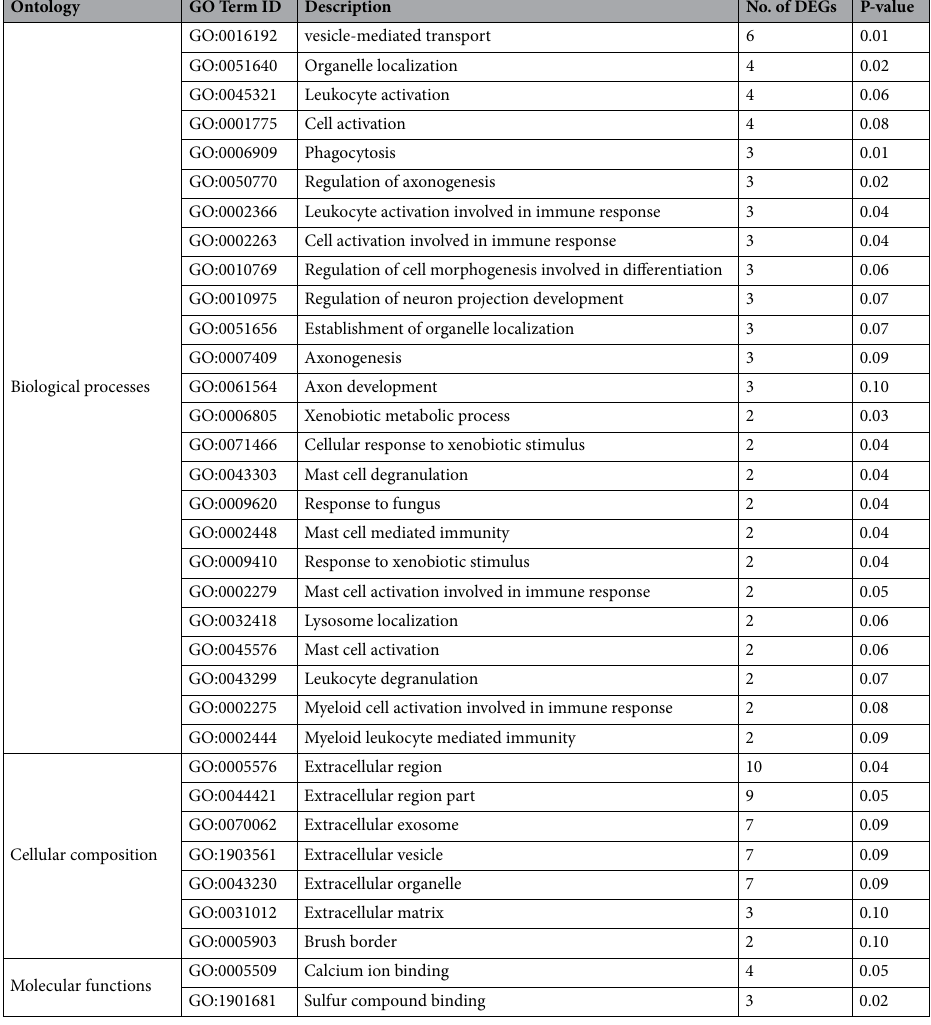
Table 4. Gene ontology of differentially expressed genes in HME vs LME in late fattening phases. GO: gene ontology, DEGs: differentially expressed genes.